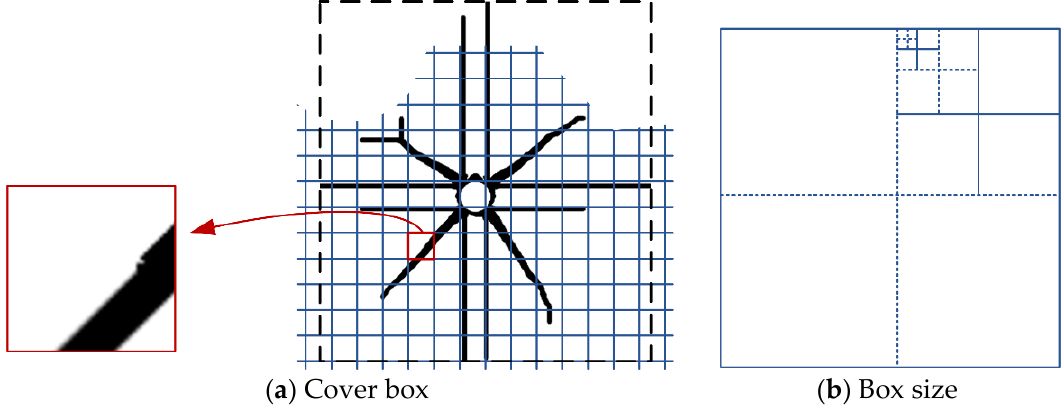
Figure 14. Schematic diagram of fractal box dimension calculation principle.